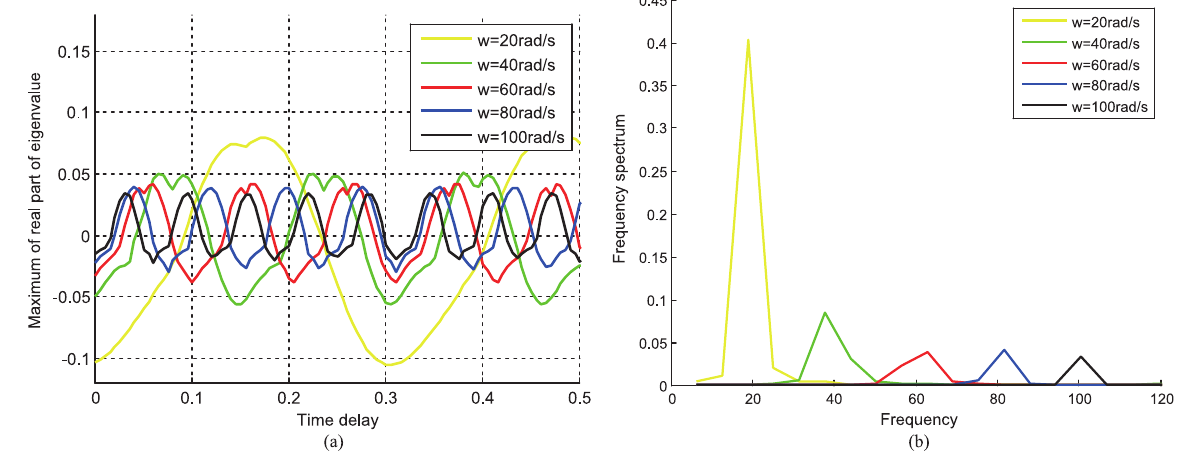
Fig. 7. Effect of time delay on the stability of VVBG DVA, (a) the largest values of the real parts of characteristic roots; (b) frequency spectrum.